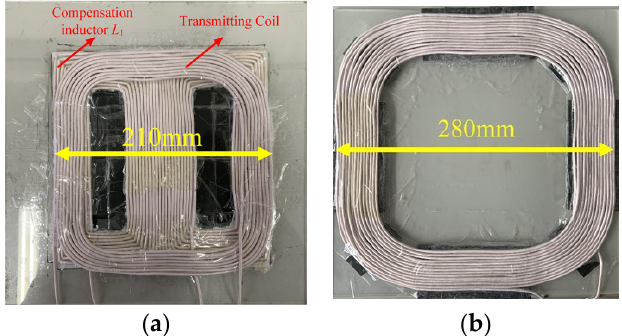
Figure 12. Experimental setup of the proposed LC/S compensated IPT system: ( a ) transmitting pad, ( b ) receiving pad. Table 4. Measured values of specific parameters in the proposed LC/S compensated IPT system.